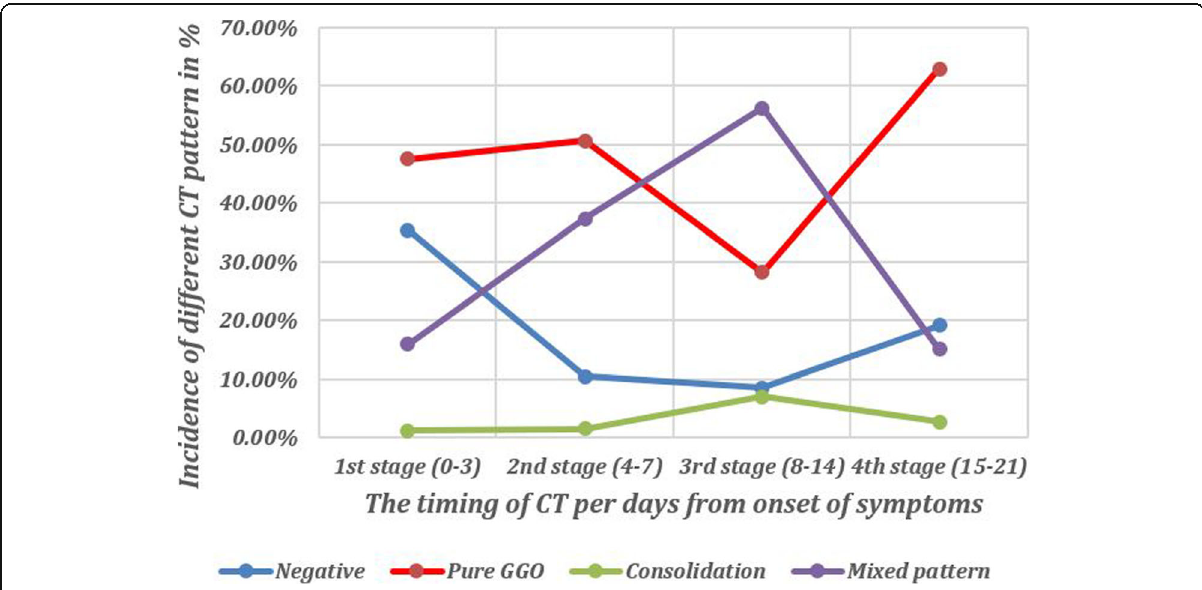
Fig. 3 A diagram showing the changes in the incidence of different CT patterns along the different stages of follow-up of cases